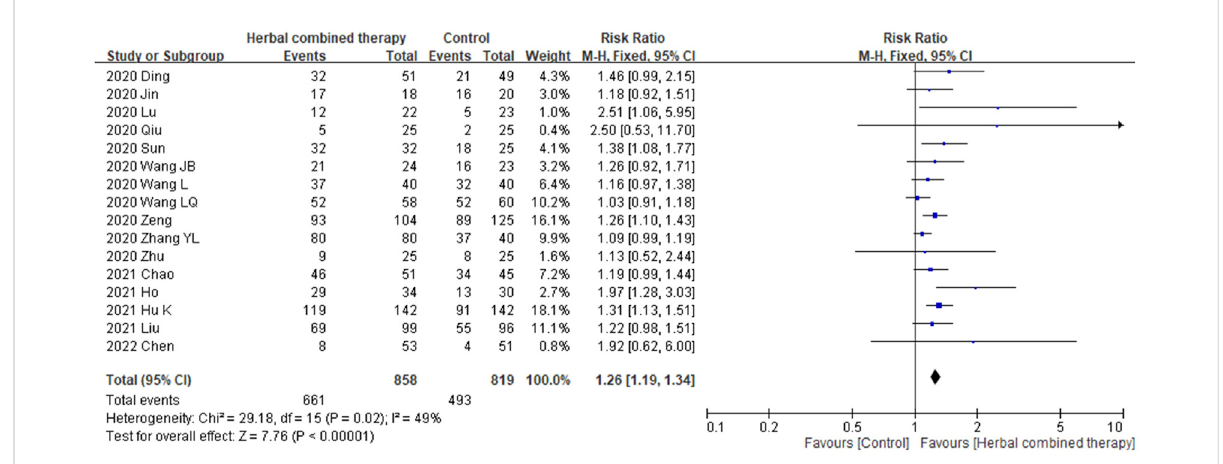
FIGURE 5 Forrest plot of the effects of HM combined therapy in chest CT improvement.